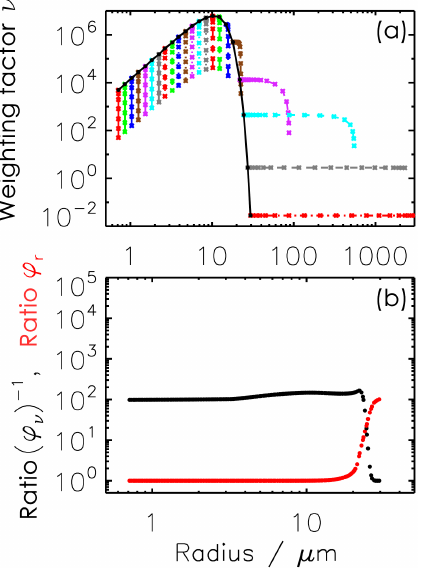
Figure 3. Top: ( r i ,ν i ) evolution of selected SIPs for AIM. The black line shows the initial distribution. Each coloured line con- nects the data points that depict the ( r i ,ν i ) pair of an individ- ual SIP every 200s. Bottom: the ratios ϕ r and ϕ ν are defined as r i (t 3600s )/r i (t 0s ) and ν i (t 3600s )/ν i (t 0s ) . ϕ r (red = = = = curve) and (ϕ ν ) − 1 (black curve) for all SIPs are shown as a func- tion of their initial radius r i (t 0s ) . An example simulation with = Long kernel, singleSIP-init, (cid:49)t 10s , κ 40 and N SIP 197 is = = =